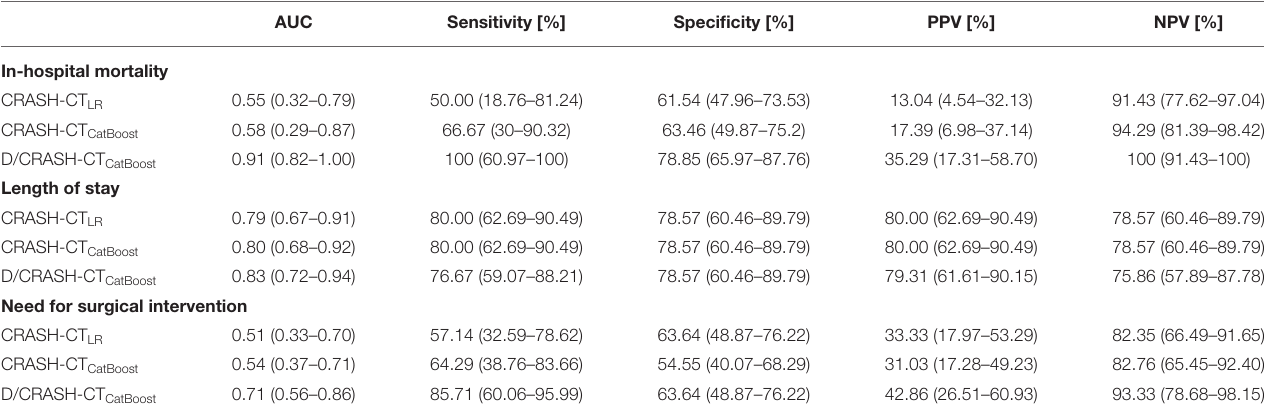
TABLE 5 | Comparison of prognostic models for predicting alternative outcome measures based on LOOCV. AUC Sensitivity